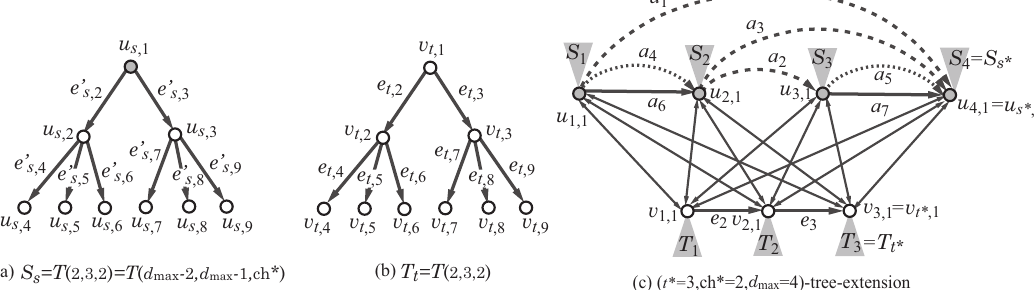
Figure 8. An illustration of a tree-extension, where the vertices in V ( K ) are depicted with gray circles: ( a ) The structure of the rooted tree S s rooted at a vertex u s ,1 ; ( b ) the structure of the rooted tree T t rooted at a vertex v t ,1 ; ( c ) the ( a , b , c ) -tree-extension of the scheme graph in Figure 2d for a = t ∗ = 3, b = ch ∗ = 2 and c = d max =